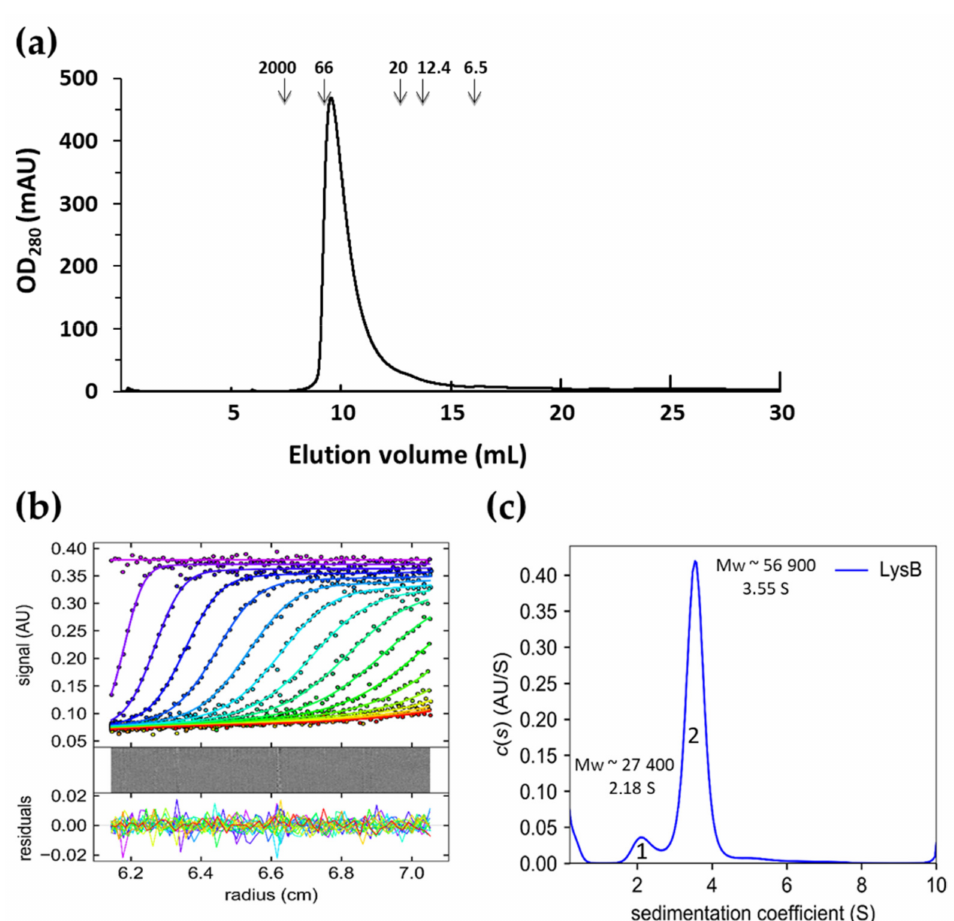
Figure 8. Size-exclusion chromatography and sedimentation velocity analytical ultracentrifugation analysis of LysB. ( a ) Elution profile of LysB endolysin on Superdex 75 sizing column. LysB endolysin (3 mg/mL) in a final volume of 300 µ L was loaded on Superdex 75 10/300 GL (AKTA Pure chromatography system, GE Healthcare, Little Chalfont, UK) and eluted at a flow rate of 0.8 mL/min in buffer consisting of 25 mM NaH 2 PO 4 , 150 mM NaCl, pH 8.0. Elution of LysB endolysin was detected by absorption at 280 nm (mAU, milli-absorbance units). The position of molecular mass standards are shown as arrows: dextran blue: 2000 kDa, bovine serum albumin: 66 kDa, trypsin inhibitor: 20 kDa, cytochrome C: 12.4 kDa, aprotinin: 6.5 kDa. ( b ) Sedimentation velocity data were overlaid with the best-fit curves (lines) obtained from sedimentation coefficient distribution analysis. For the clarity of the drawing, only every fifth scan and fifth data point are shown. Below, residuals of the experimental fits. ( c ) Sedimentation coefficient distributions (c(s)) of LysB endolysin. Peak 1 corresponds to LysB monomer; peak 2 corresponds to LysB